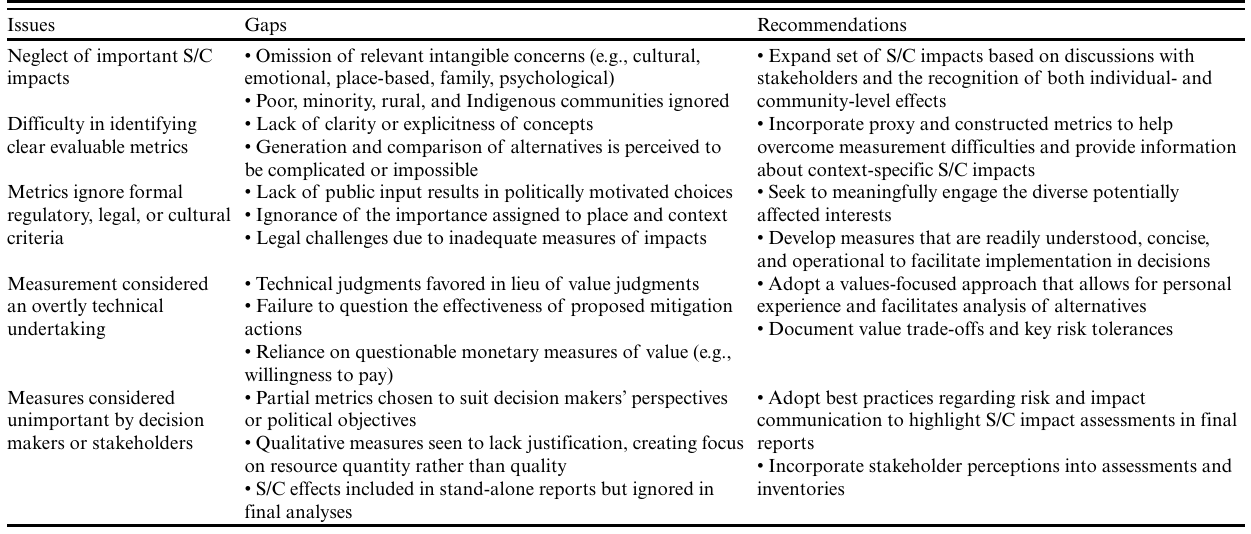
Table 1. The promise and reality of social and cultural (S/C) metrics, and eight recommendations for closing the